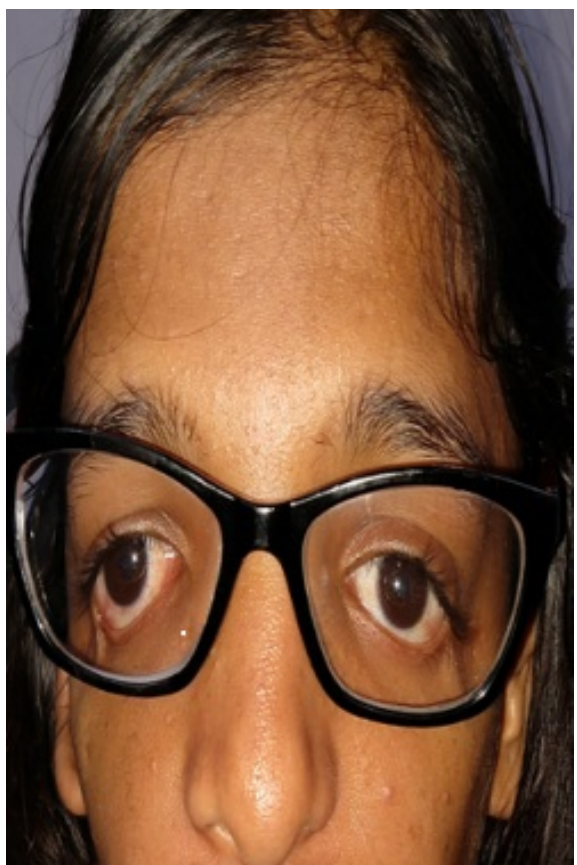
Figure 1: The facial dysmorphic features of Treacher Collins syndrome